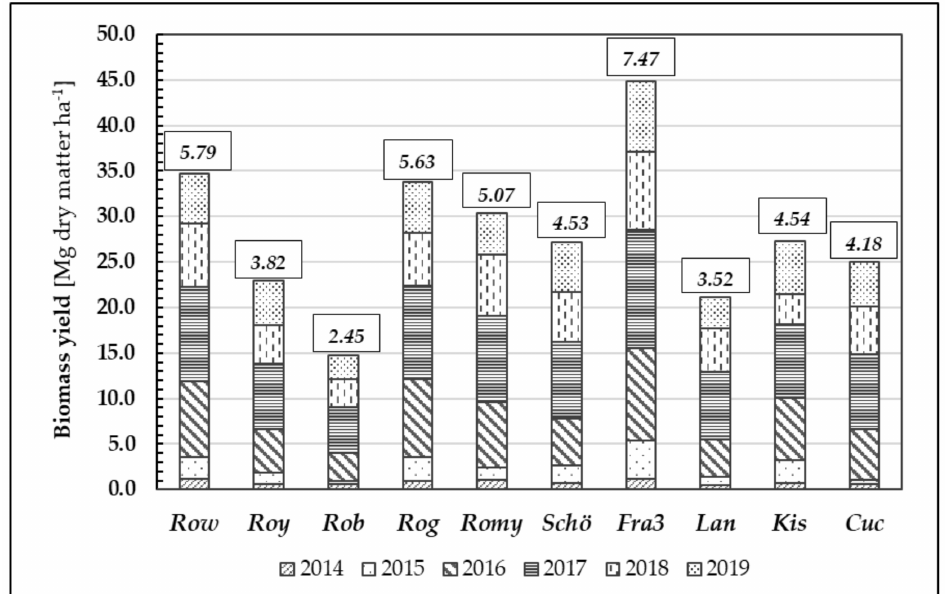
Figure 8. Biomass growth [Mg dry matter ha − 1 ] through the years 2014–2019 of different Robinia test units; data given in small boxes represent individual average increment of biomass [Mg dry matter ha − 1 ] in 6 years of